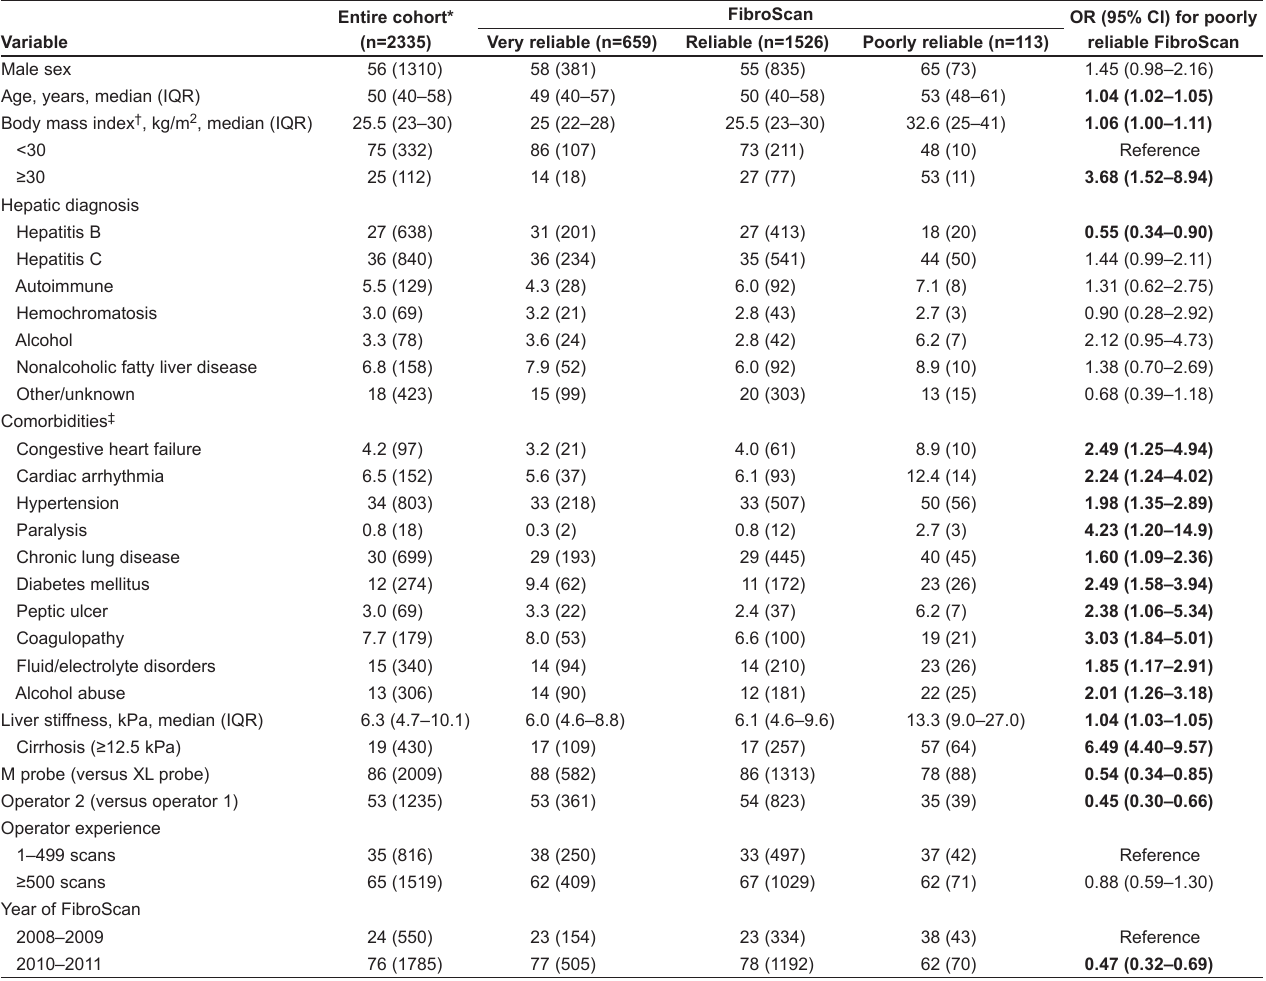
Table 1 Characteristics of the study cohort according to the reliability of liver stiffness measurement